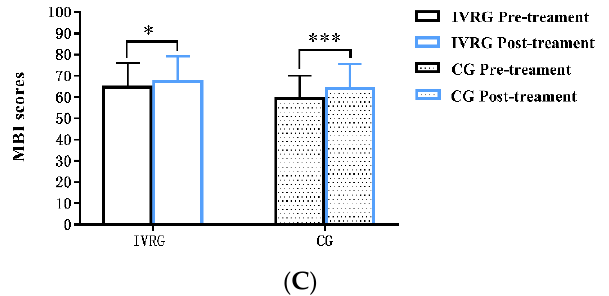
Figure 3. Bar plots for comparison of MOCA ( A ), TMT-A ( B ), and MBI ( C ) between the IVRG and CG before and after treatment. Significant differences were observed in intragroup. *, p < 0.05; **, p < 0.01; ***, p < 0.001. Abbreviation: MOCA, Montreal cognitive assessment; TMT-A, trail-making test-A; MBI, modified Barthel index; IVRG, immersive virtual reality group; CG, control group.